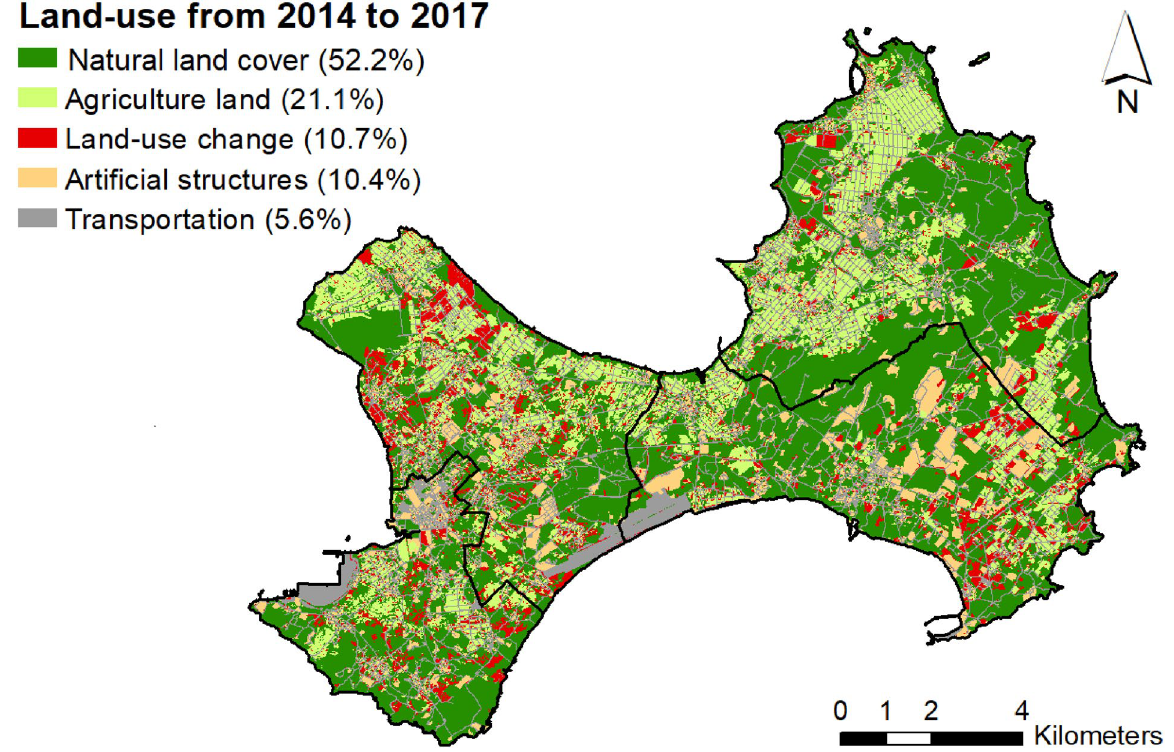
Figure 4. Spatial distribution of land-use change variable between 2014 and 2017. This map is generated by ArcGIS 10.7 19